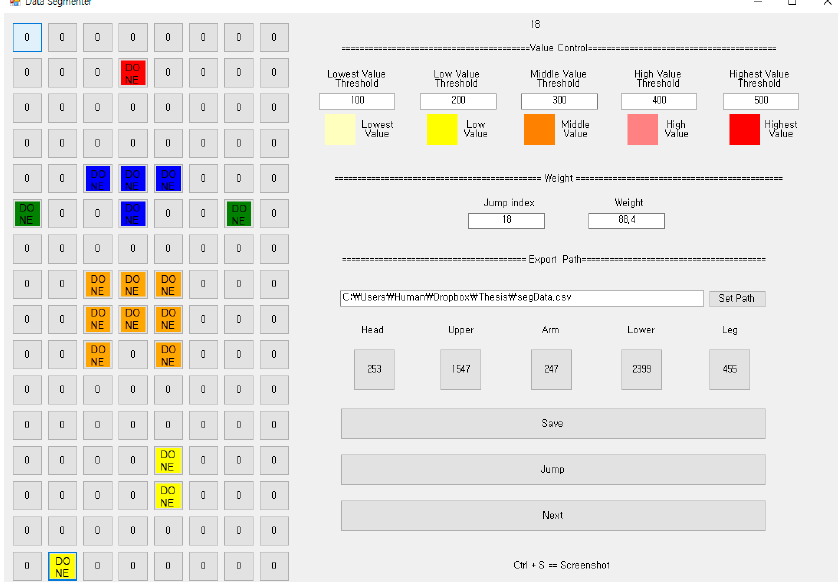
Figure 8. The result of the discrimination of the five body parts.